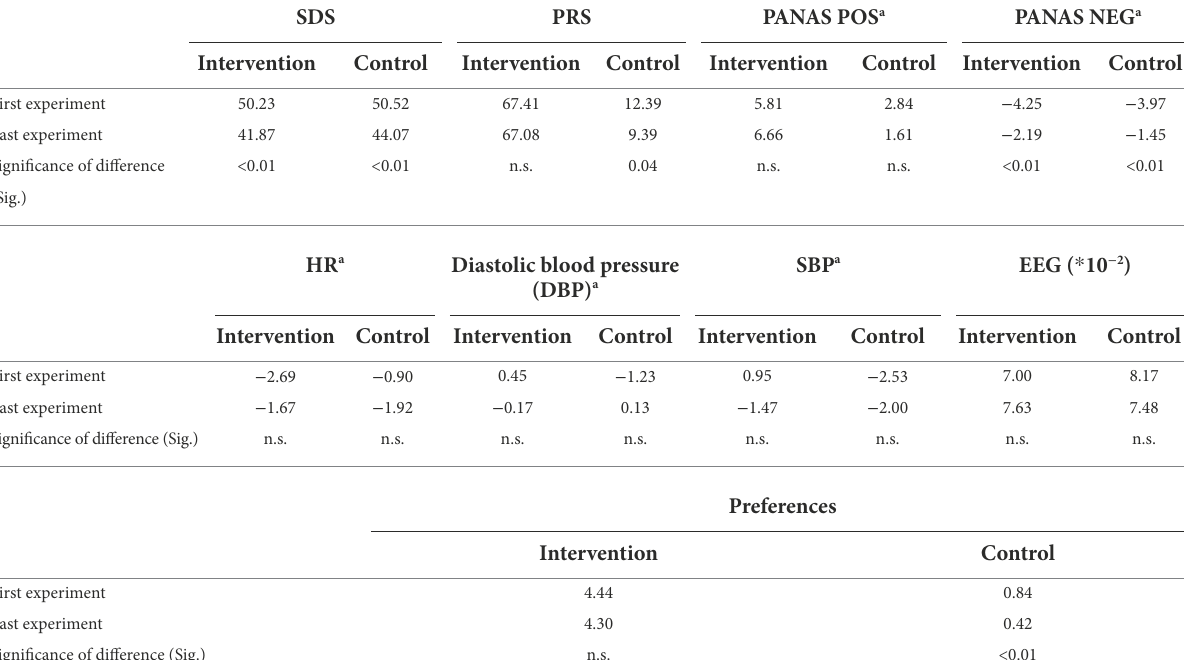
TABLE 4 The results of the paired T -test examining the various psychophysiological indicators between the first and the last experiments (one- week